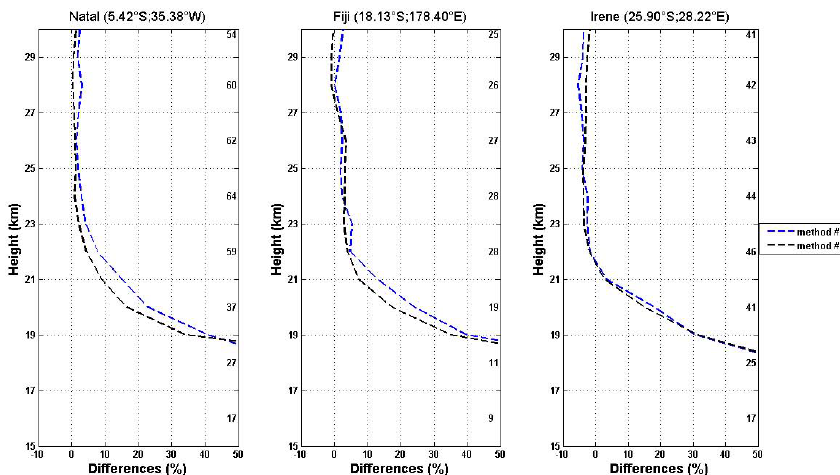
Fig. 8. Comparison results between the co-location method and the method applied without the time criterion. Method #1 (blue dashed lines) indicates the mean differences between all the paired GOMOS and SHADOZ profiles. And method #2 (black dashed lines) indicates the method applied without the time criterion. The numbers on the right vertical axis indicate the number of coincident pairs used at that altitude level for the method